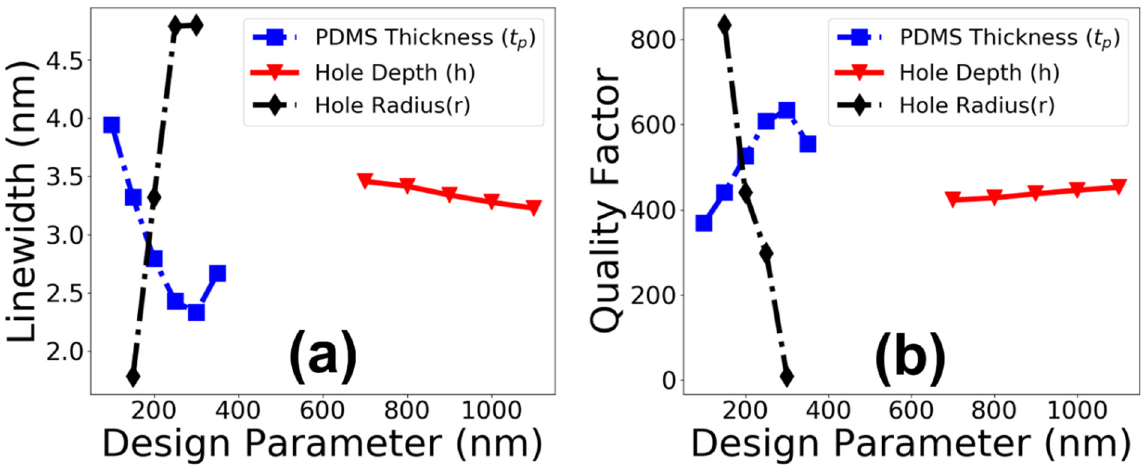
Figure 3. Refractive index variation of PDMS as a function of ambient temperature.